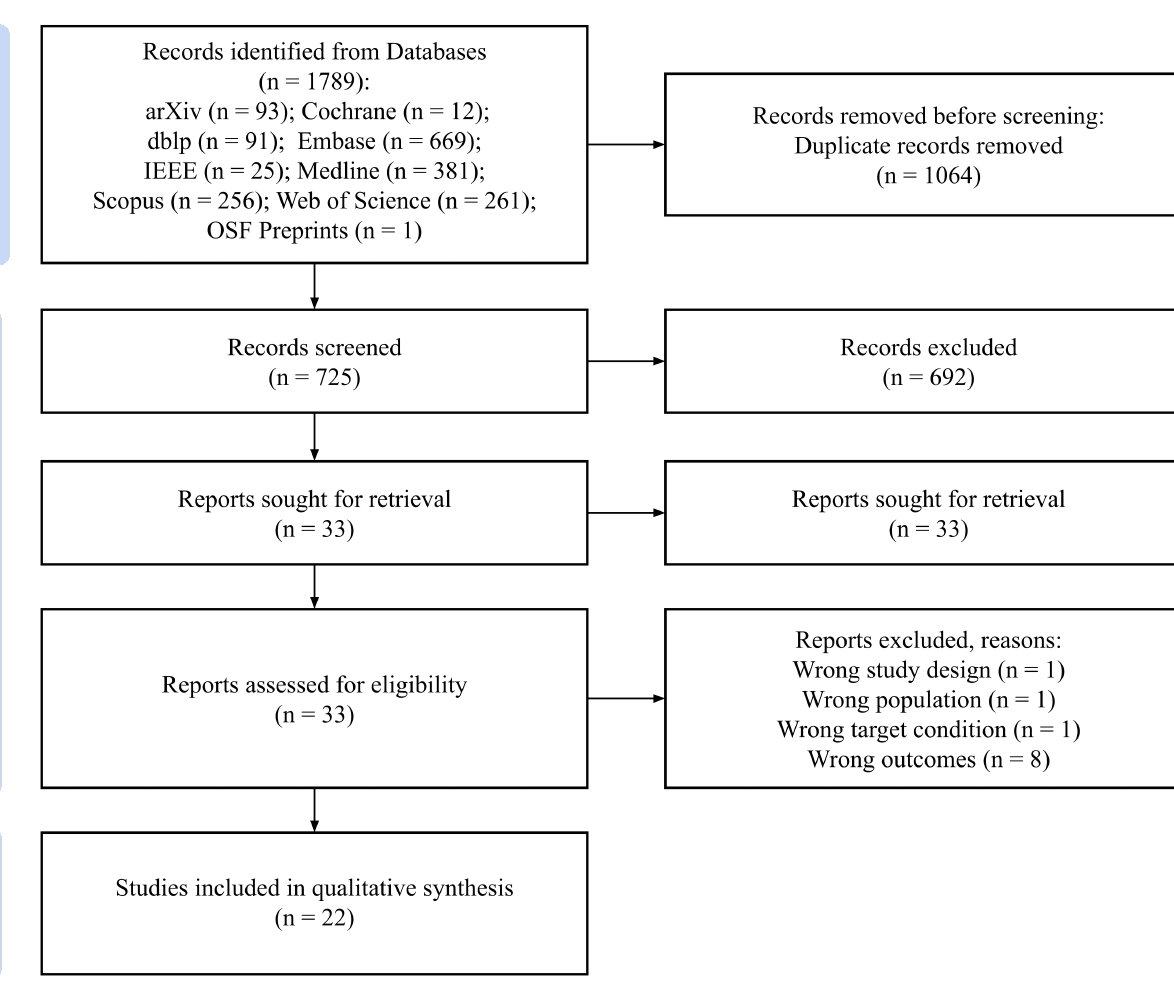
Figure 1. PRISMA flow